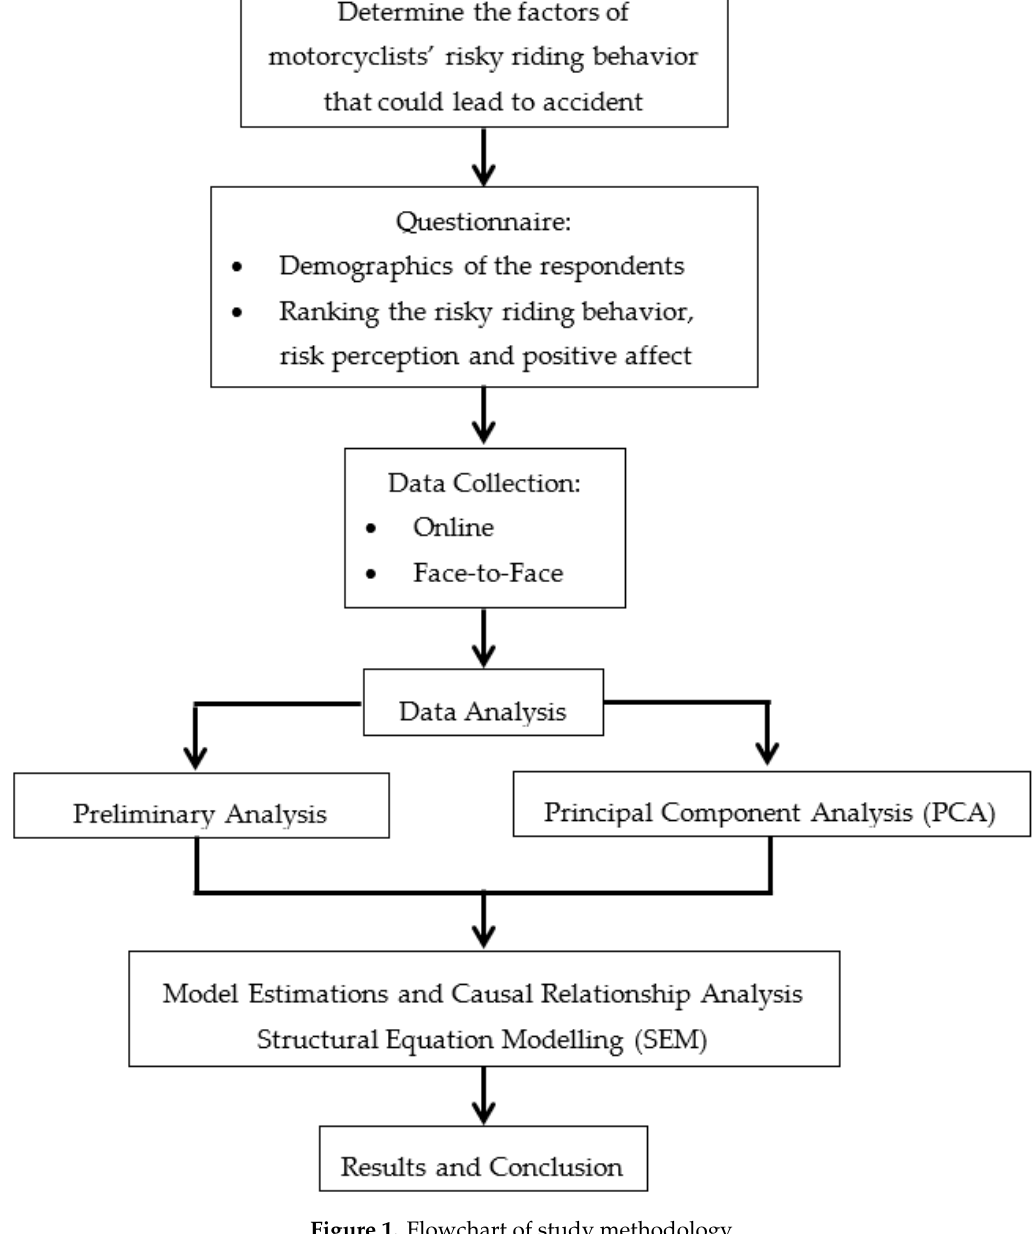
Figure 1. Flowchart of study methodology.